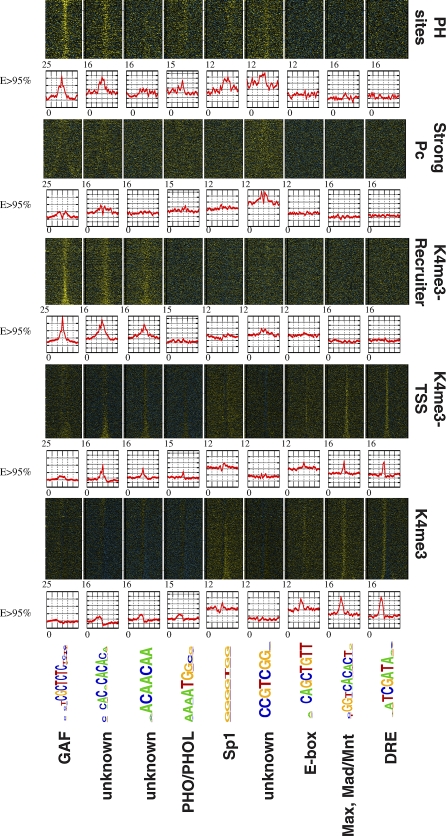
Overrepresented Sequence Motifs in the Different Spatial ClustersShown are data for motifs that distinguish clusters or groups of clusters. The motifs were identified with no prior assumptions, but include the known GAF site [32]; PHO site [33]; Sp1/KLF site [38]; E-box [37] Max, Mad/Mnt site; and DRE site [36]. For each inferred position weight matrix (PWM), we computed the predicted binding energy for bins of 100 bp [35] and plotted a color-coded representation of it in the 8 kb around the center of each cluster (yellow indicates stronger binding). We polarized the clusters according to the strand of the nearest TSS. For each motif and cluster, we also plotted the percentage of probes with predicted binding strength in the top 5% (y-axis) in the 6 kb around the clusters' centers (x-axis).